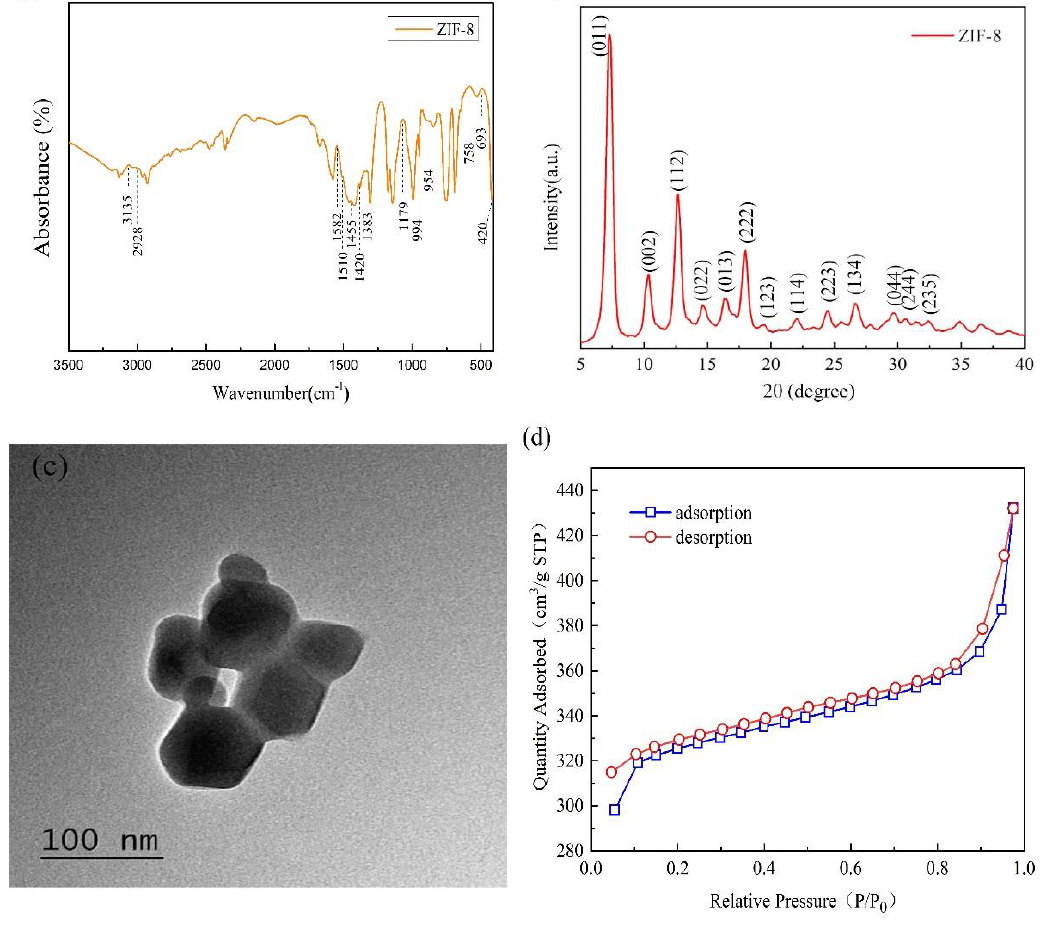
Figure 2. ( a )Fouriertransforminfrared(FT-IR)spectrum, ( b )X-raydiffraction(XRD)chart, ( c )transmission Figure 2. ( a ) Fourier transform infrared (FT-IR) spectrum, ( b ) X-ray diffraction (XRD) chart, ( c ) electron microscopy (TEM) image, and ( d ) adsorption–desorption curves of transmission electron microscopy (TEM) image, and ( d ) adsorption–desorption curves of ZIF-8.